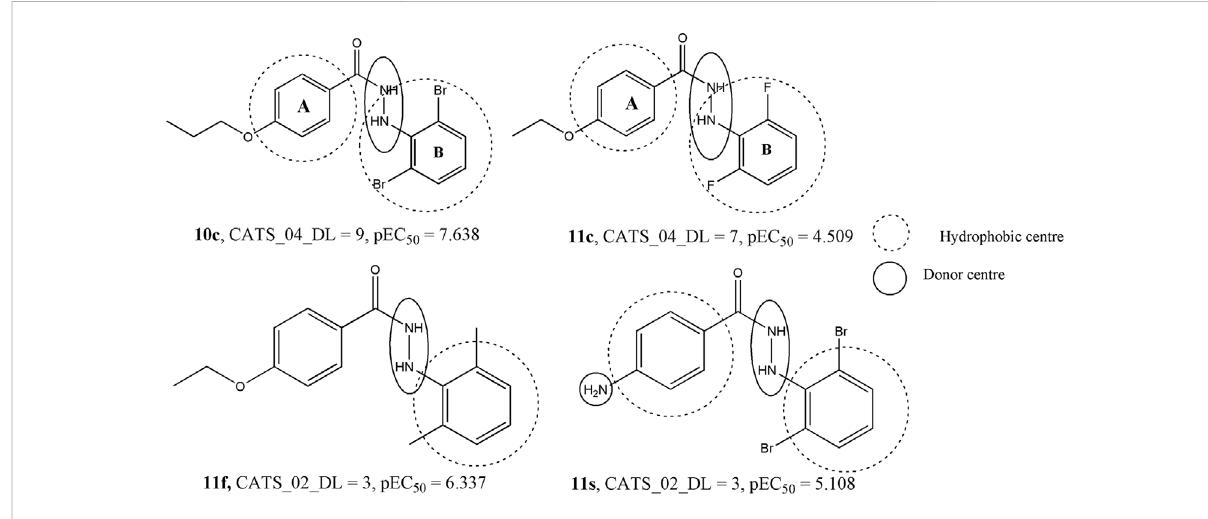
FIGURE 5 Signi fi cance of the CATS2D descriptors with respect to the dataset